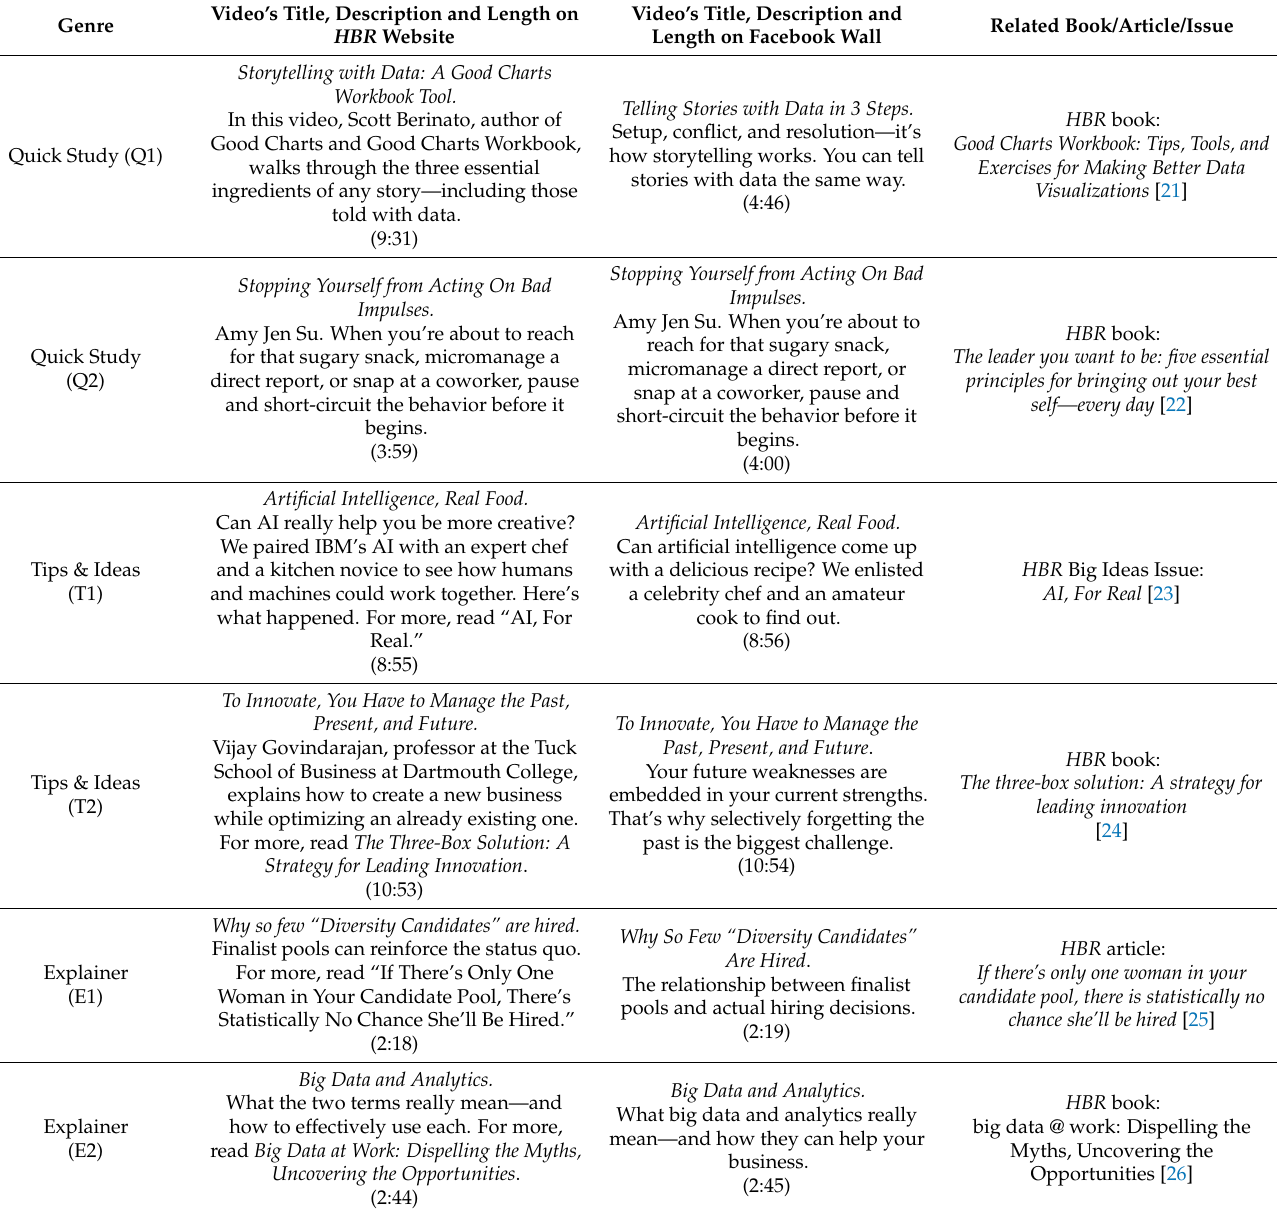
Table 2. Overview and description of the HBR genres